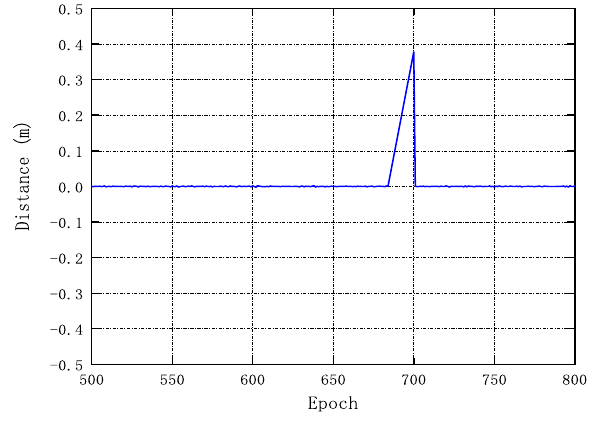
Figure 5. Real data with real cycle slips detection results obtained by the proposed indoor dual- frequency cycle slip method.